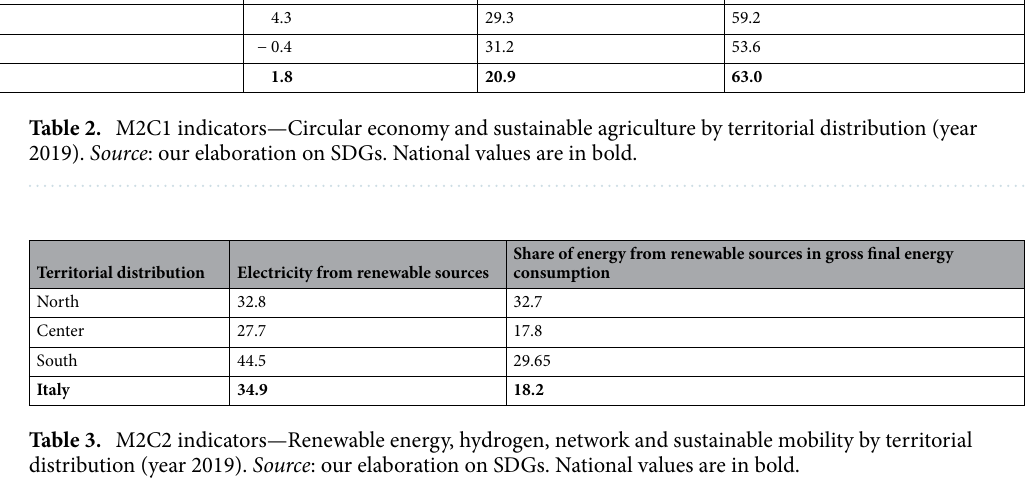
Table 3. M2C2 indicators—Renewable energy, hydrogen, network and sustainable mobility by territorial distribution (year 2019). Source : our elaboration on SDGs. National values are in bold.